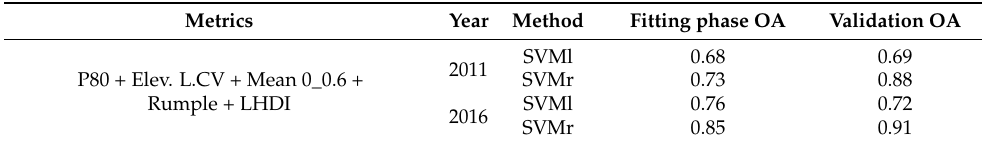
Table 8. Comparison between support vector machine with radial kernel (SVMr) and support vector machine with linear kernel (SVMl) classification method using overall accuracy for the selected metrics based on Spearman correlation. OA stands for overall accuracy.